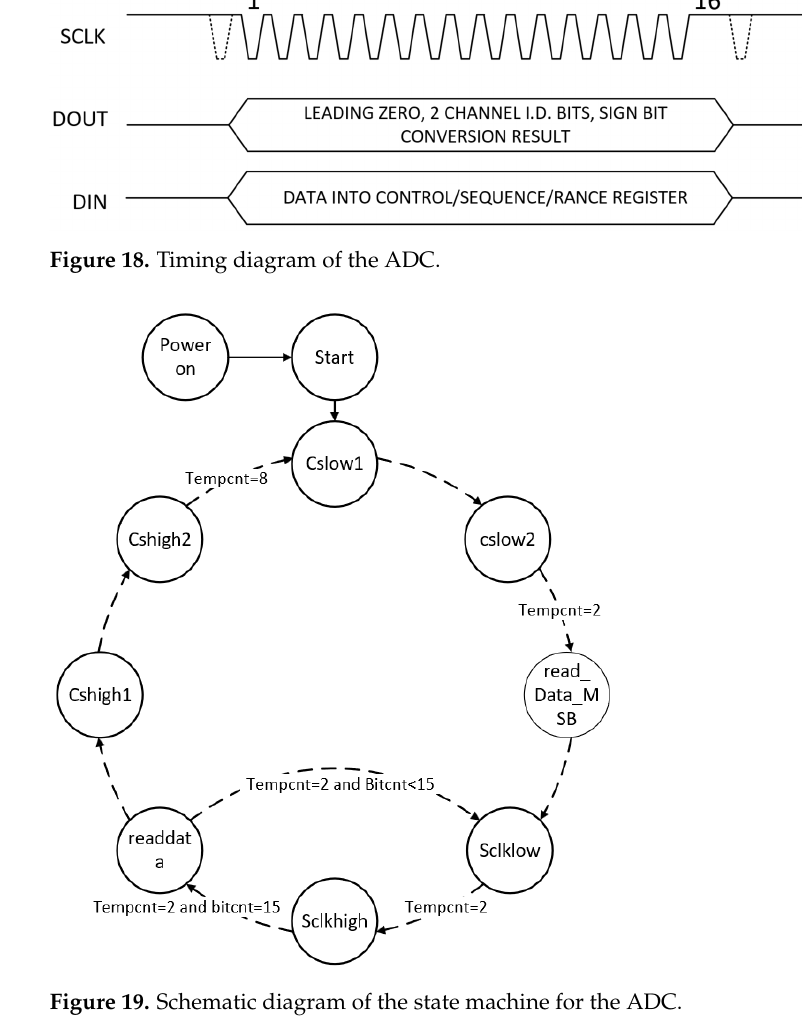
Figure 19. Schematic diagram of the state machine for the